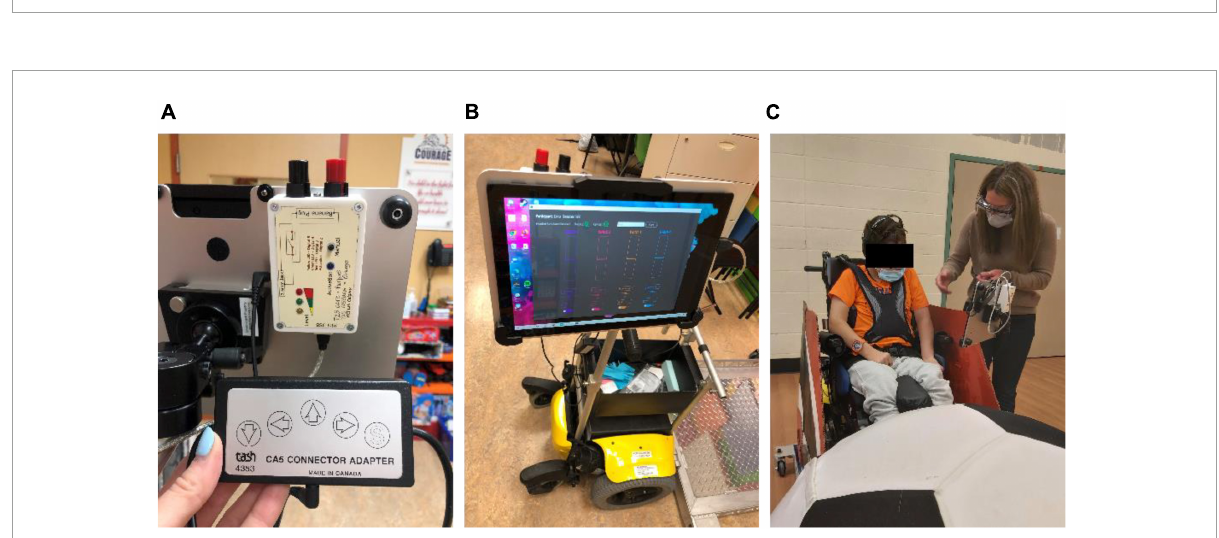
FIGURE3 BCI-to-switch interface. (A) The BCI-to-switch interface device, connected to the “forward” driving command of the wheelchair switch controls; (B) the BCI-to-switch interface custom software, displaying system controls and visual feedback to the user on a tablet computer; (C) the BCI-to-switch interface and tablet computer mounted to the PMTD in the participant’s line of sight.